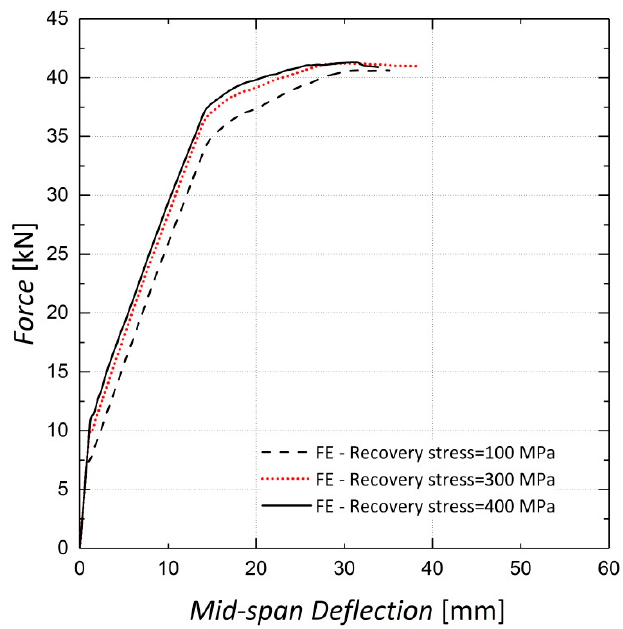
Figure 23. Load–deflection results—steel rebar diameter of 16 mm.